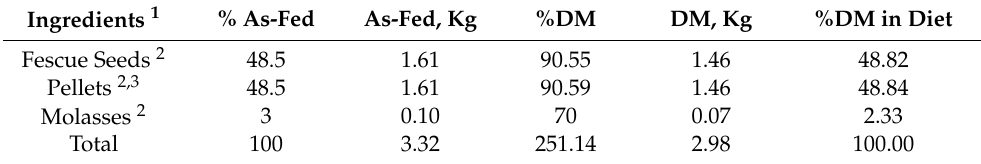
Table 1. Composition of the diet received by dams and offspring (as fed and in dry matter basis). Ingredients